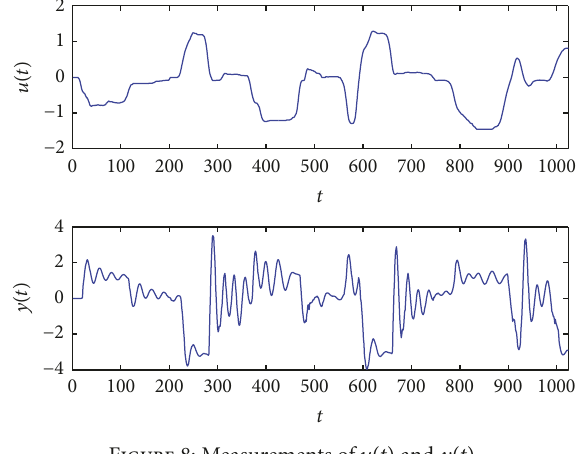
Figure 8: Measurements of 𝑢(𝑡) and 𝑦(𝑡) .